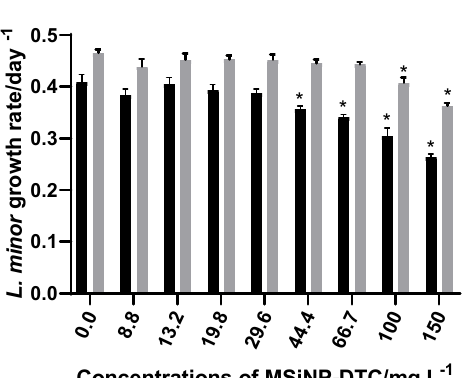
Figure 8. Average growth rate (day −1 ) calculated based on frond number (black bars) and on frond dry weight (grey bars) of L. minor exposed to DTC and DMSO 0.5% ( v / v ) ( a ), MSiNPs ( b ), and MSiNP-DTC ( c ). Error bars represent the standard deviation, and * corresponds to significant differences from the control (Dunnett’s test: p < 0.05). The concentrations of MSiNP-DTC are based on MSiNPs. The amount of DTC in 150 mg L − 1 of MSiNPs is 7.18 mg L − 1 .